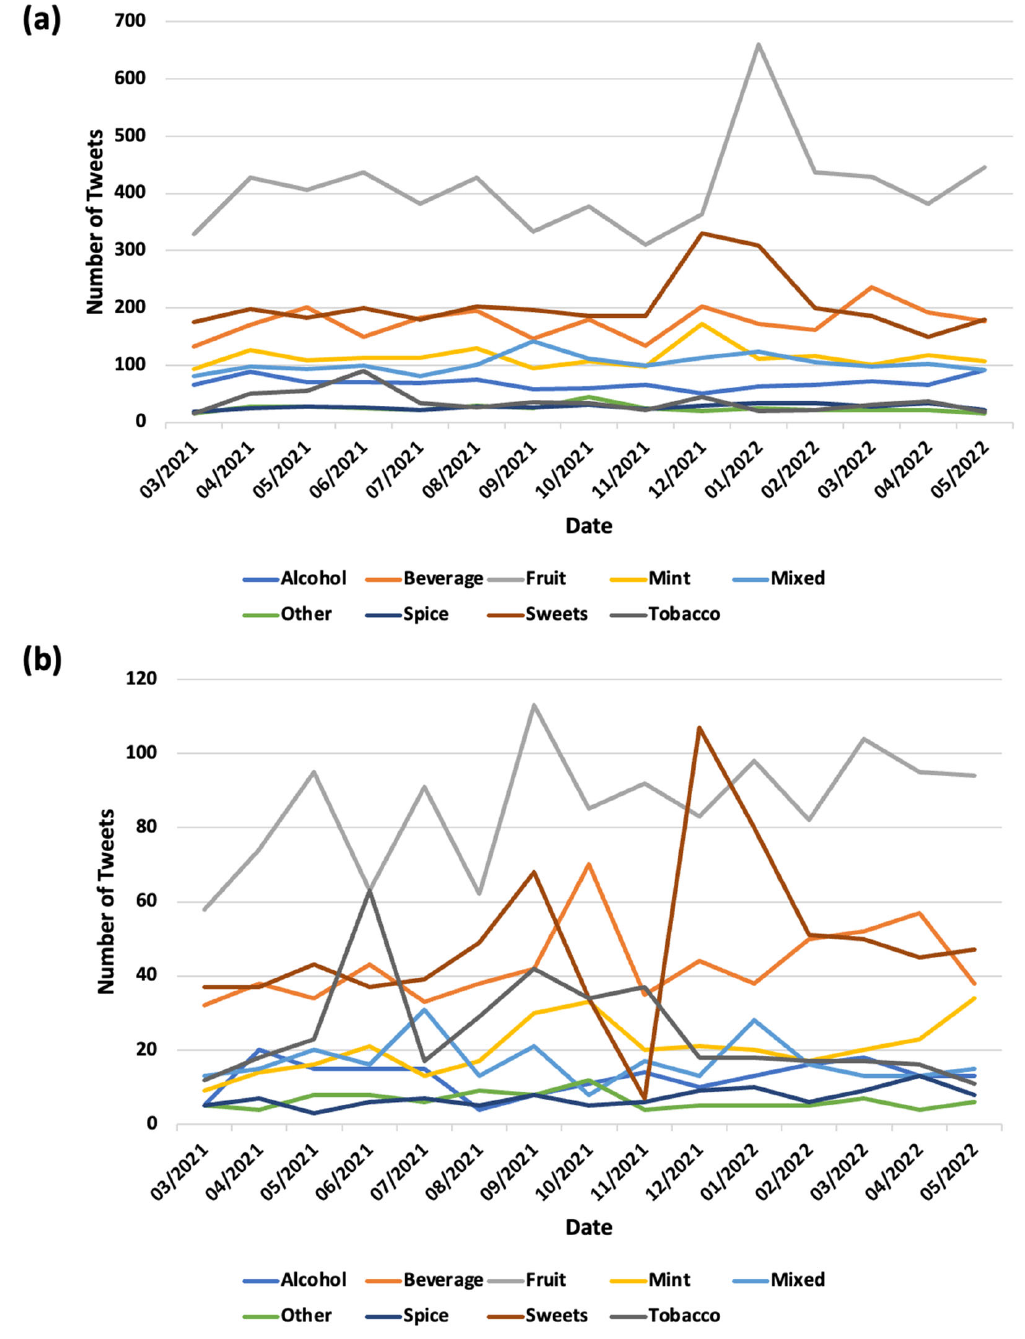
Figure 2. Longitudinal trends of waterpipe flavors mentioned on Twitter. ( a ) promotional tweets, ( b ) non ‐ promotional tweets.